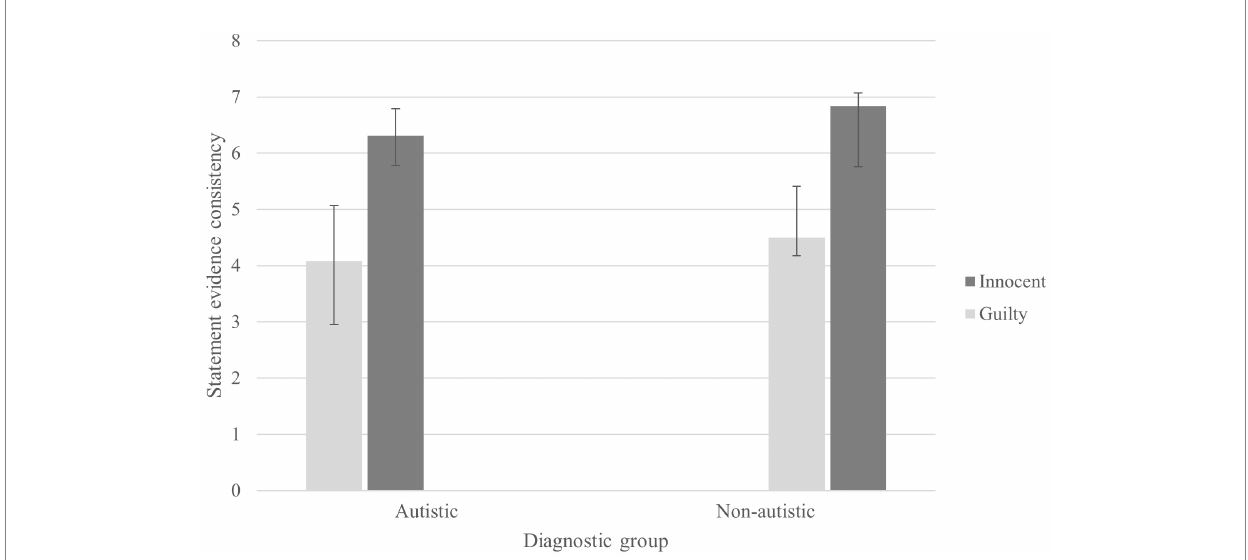
FIGURE 2 Mean statement evidence consistency scores for autistic and non-autistic groups in innocent and guilty conditions (with BCa 95% confidence error bars).